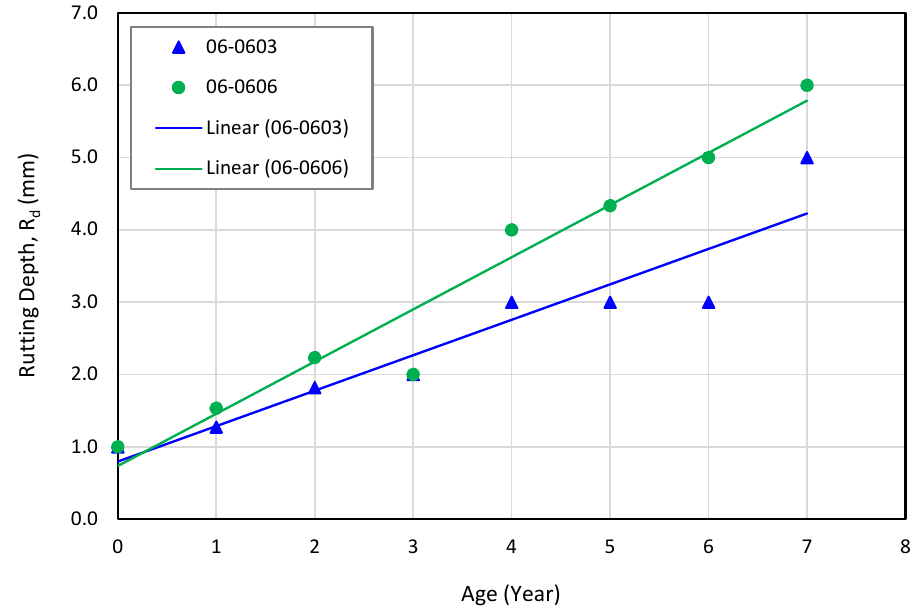
Figure 9. Rutting progression on the LTPP test sections located in CA.